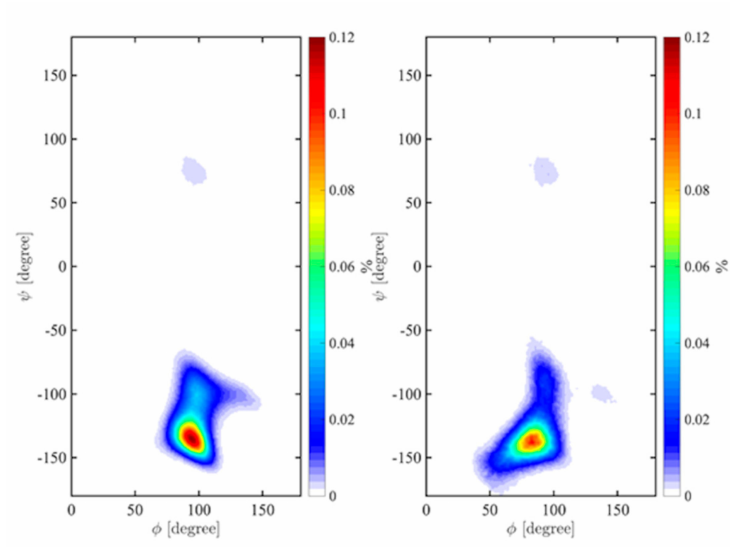
Figure 8. Probability density maps for α -D-Gal p -(1 → 3)- α -D-Glc p in vacuum ( left ) and in explicit solvent ( right ) after a 1 µ s MD simulation at 300 K. Negative ф are neglected for readability as no point occurs in that region, in agreement with fully relaxed